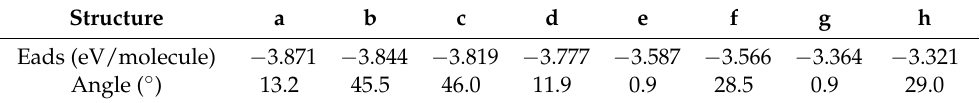
Table 1. The adsorption energies and rotation angles of a DAT molecule on a Cu(001) surface in different adsorption configurations. The detailed structural configurations are given in Figure 1.